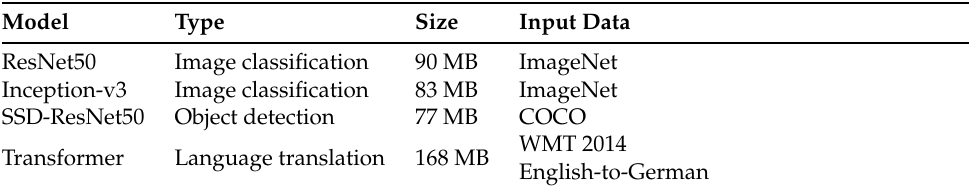
Table 1. ML models used in the